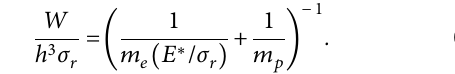
Table 1: Mechanical properties of Q235 steel and 2219Al. Material